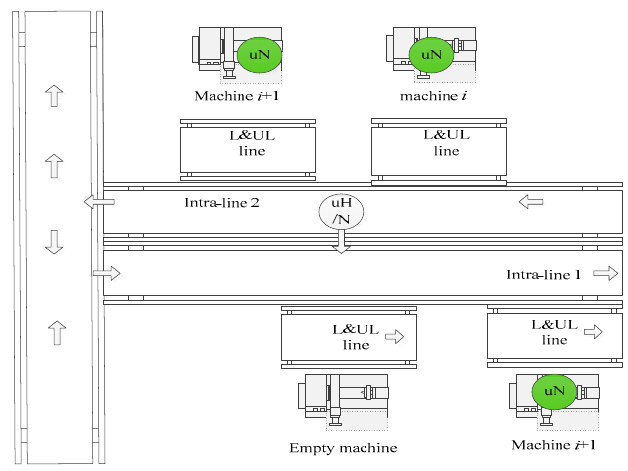
Figure 9. Directly move an uL to Intra-Line 1 from Intra-Line 2 (Rule 5). Appl. Sci. 2017 , 7 , 780